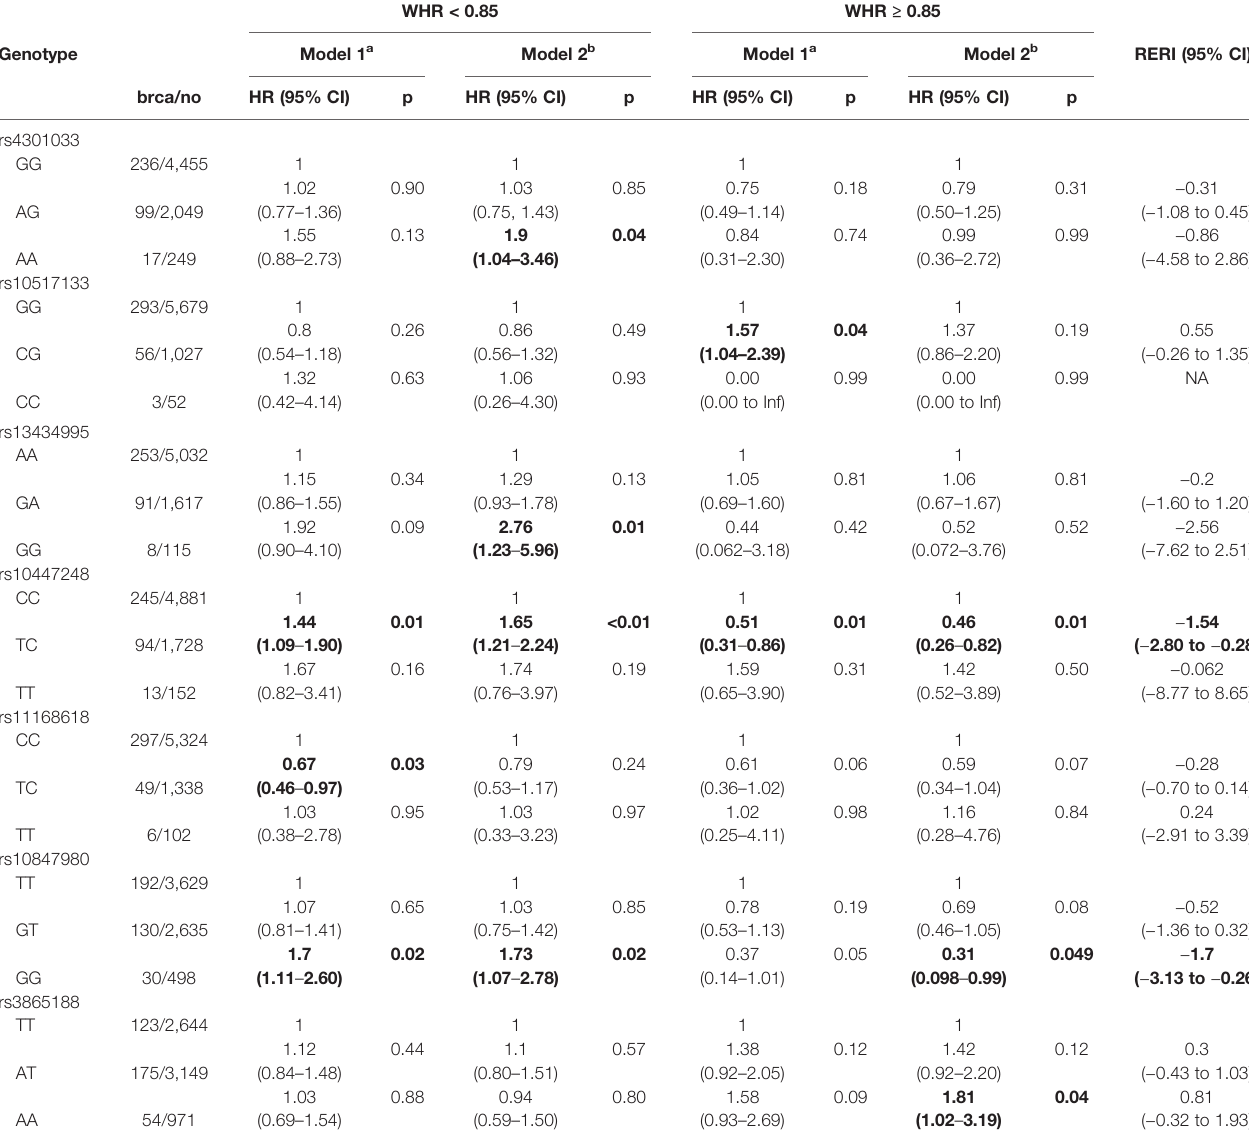
TABLE 4 | Association between adiponectin-related SNPs and postmenopausal invasive breast cancer risk, by WHR status. WHR < 0.85 WHR ≥ 0.85 Genotype Model 1